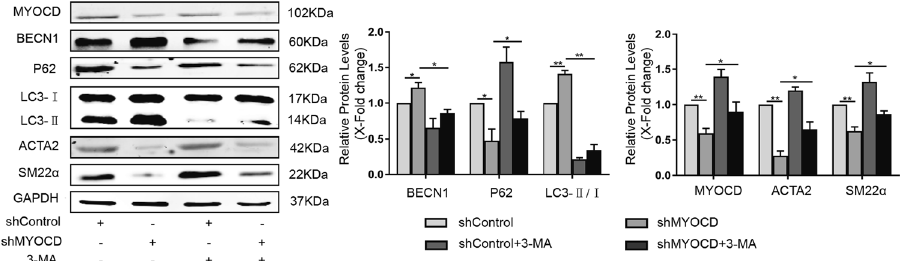
Fig. 2 Inhibition of autophagy in MYOCD-knockdown cells restored the expression of contractile proteins. HA-VSMCs were transfected with shMYOCD plasmid for 4 h and then treated with 5 mM 3-MA for another 48 h. Western blot images and quanti fi cation in each group were shown (* P < 0.05, ** P < 0.01, n = 3).